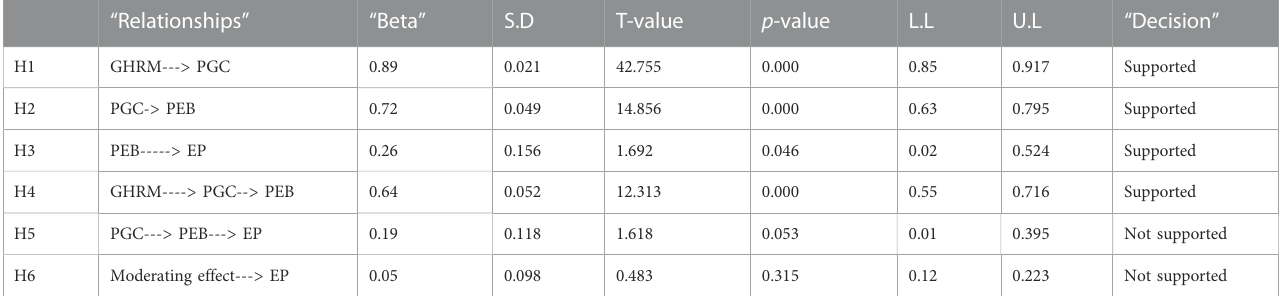
TABLE 3 Path analysis. “ Relationships